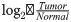
Pilot HNSCC driver–passenger discrimination via human–dog comparison.(A) Driver-passenger discrimination of human 8q. Human 8q is broken into dog chromosomes 29 (chr29) and 13 (chr13), with the numbers indicating the sequence coordinates. In human HNSCCs, the entire human 8q and all genes encoded (398 total) are recurrently amplified, as represented by a broken lined bar. In canine tumors, however, only chr13 is significantly amplified resulting in 125 genes being amplified and 85 genes unchanged, compared to only 2 genes amplified and 186 genes unchanged for chr29. The 125 amplified genes on chr13, including MYC, are considered as driver candidate genes (DCGs; in green), whereas the 186 unchanged genes on chr29 are deemed passenger candidate genes (PCGs; in red). The p-value shown is obtained with Fisher’s exact test; see S1H Table. (B) The 10Mb amplicon on chromosome 16 in tumor 240 (Fig 2B) is broken into three distinct regions in the human genome as shown. Only one region is significantly amplified in human HNSCC according to TCGA [1], and the amplified genes encoded there, including known driver FGFR1 [1], are considered as driver candidate based on our dog-human comparison strategy [30]. The p-value shown is obtained with Fisher’s exact test, see S1H Table. (C) The correlation between copy number status, represented by a gene’s log2⁡TumorNormal value, and mRNA expression level, represented by a gene’s log2(FPKM) from RNA-seq or log2(intensity) from SNP arrays. The data are from TCGA [1]. The p-values shown are obtained with Hotelling's t-squared tests, see S1H Table.